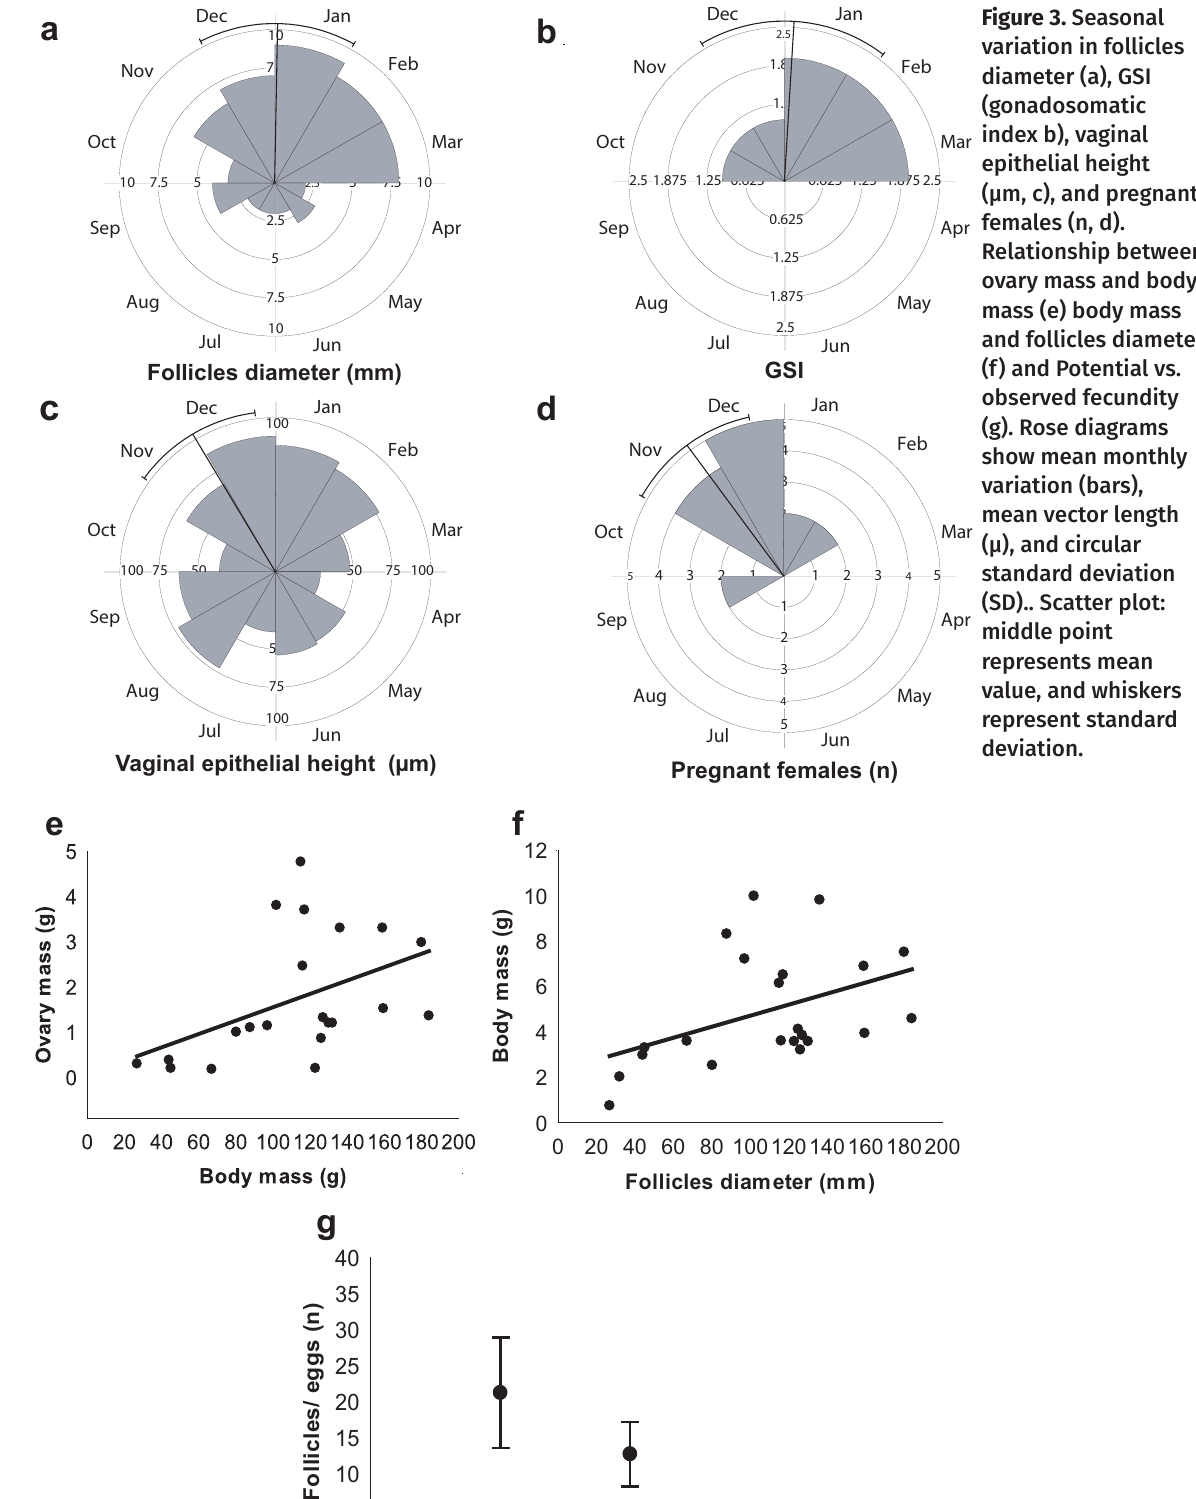
Figure 3. Seasonal variation in follicles diameter (a), GSI (gonadosomatic index b), vaginal epithelial height (µm, c), and pregnant females (n, d).